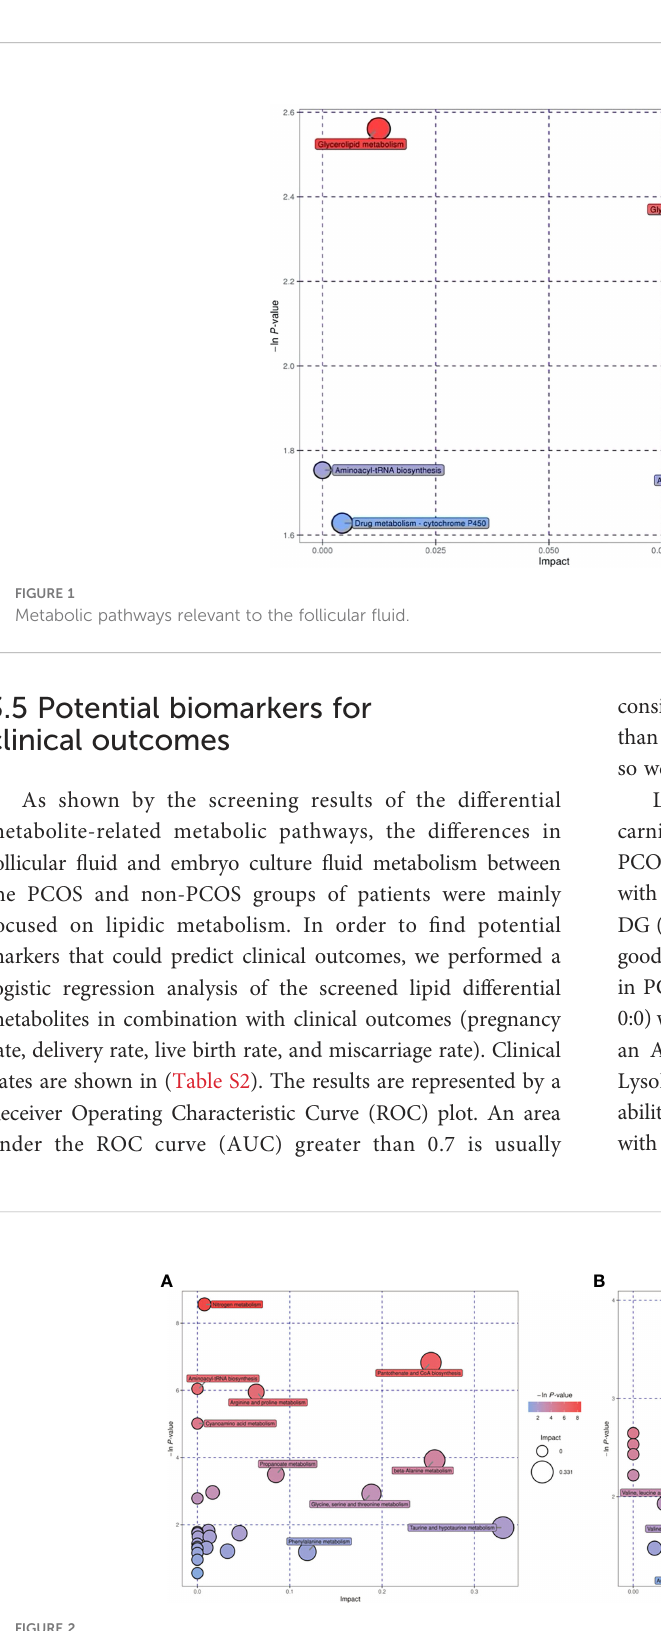
FIGURE 2 Metabolic pathways relevant to the embryo culture fl uid. (A) positive ion mode, (B) negative ion